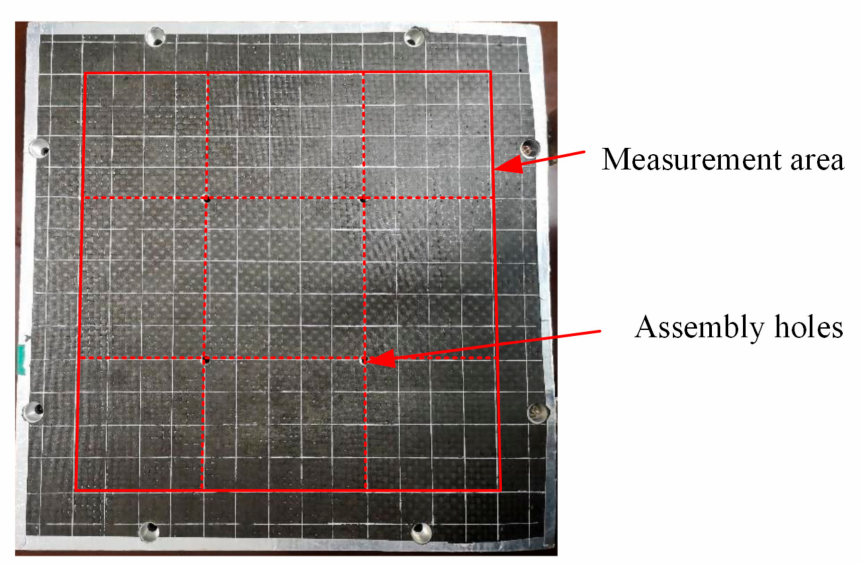
Figure 1. Honeycomb sandwich specimen and measurement area. Taking the geometric center of the measurement area as the origin, the horizontal and vertical center lines of the specimen are the X and Y axes to establish a coordinate system. The numbers and pasting positions of the nine sensors are given in Table 1. Table 1. Fiber Bragg grating (FBG) series of connections, wavelengths, and paste positions. Initial Center Wavelength λ FBG No.